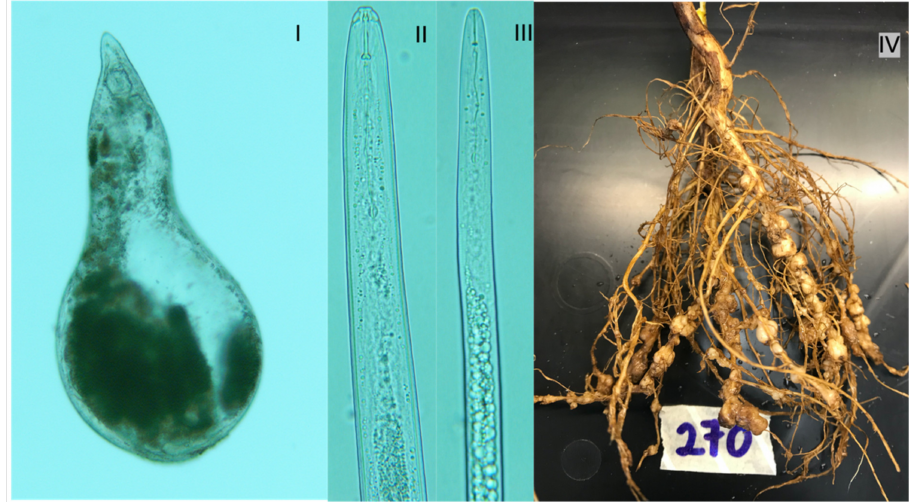
Figure 3. Microscopic view of ( I ) female M. incognita , ( II ) male M. incognita , ( III ) juvenile M. incognita (source P. Castillo, IAS-CSIC) collected from ( IV ) galled root symptoms on soybean plant (O.Z. Wohor